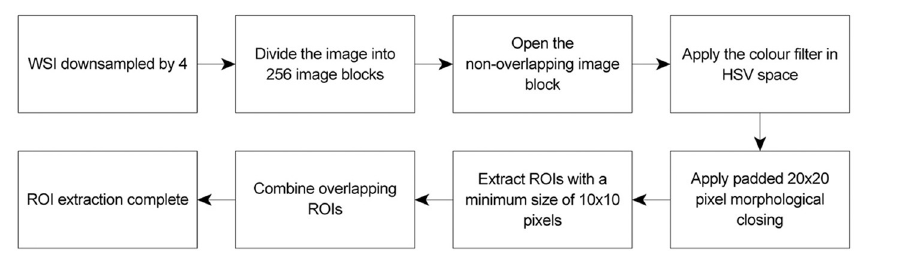
Fig 9. ROI extraction flowchart.